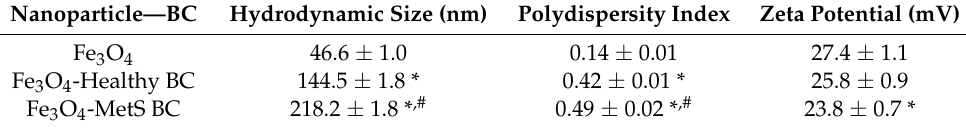
Table 2. Fe 3 O 4 NPs-biocorona